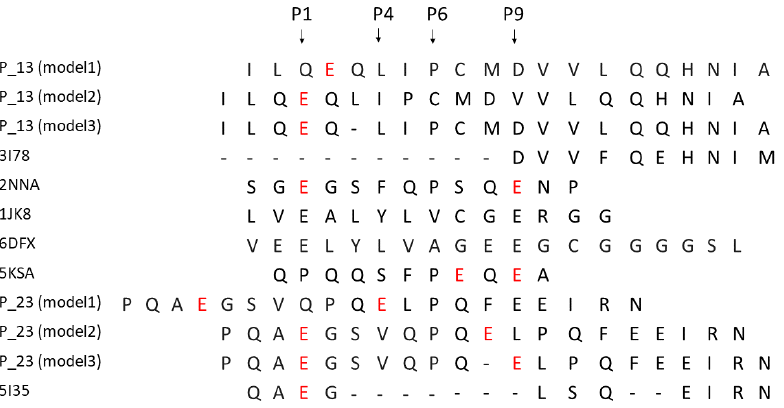
Figure 4. Alignment of p13 and p23 peptide sequences with template peptides, indicated by the PDB code, used for the modelling procedure. Three different options have been defined to obtain models labelled as model 1, model 2 and model 3 for both p13 and p23. The glutamines subjected to deamidation are in red.